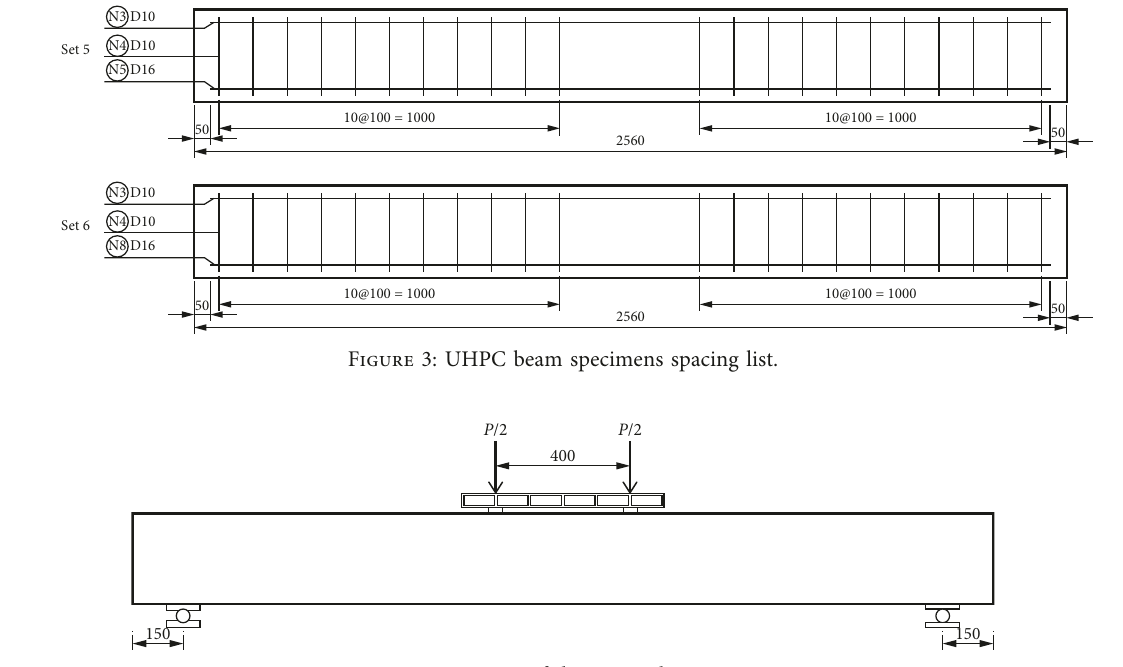
Figure 4: Setup of the UHPC beam